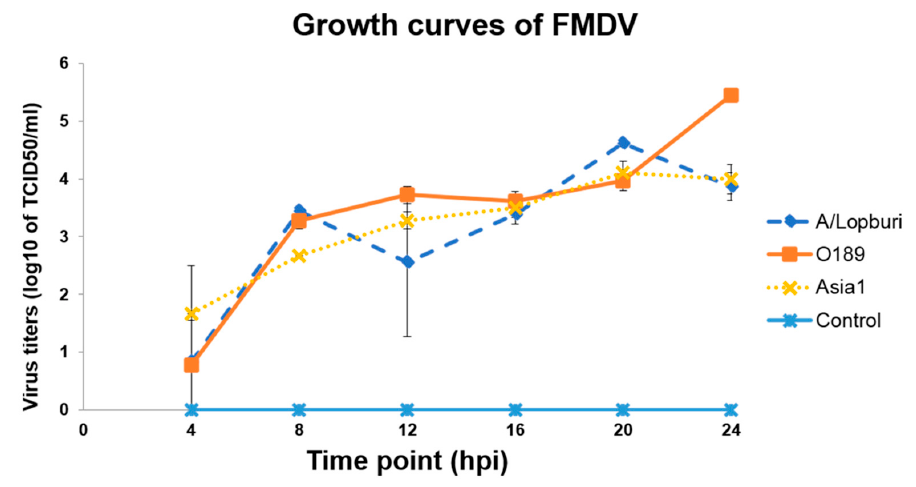
Figure 2. The growth kinetics of FMDV type A, A/Lopburi/2012, O/Tai/189/1987, and Asia1/2013 in BHK-21 cells at each time point. The cells were inoculated with each vaccine strain at 0.01 MOI. The viruses were collected for titration at 4-h intervals from 4 to 24 hpi. The bars represent the standard error of mean (SEM).